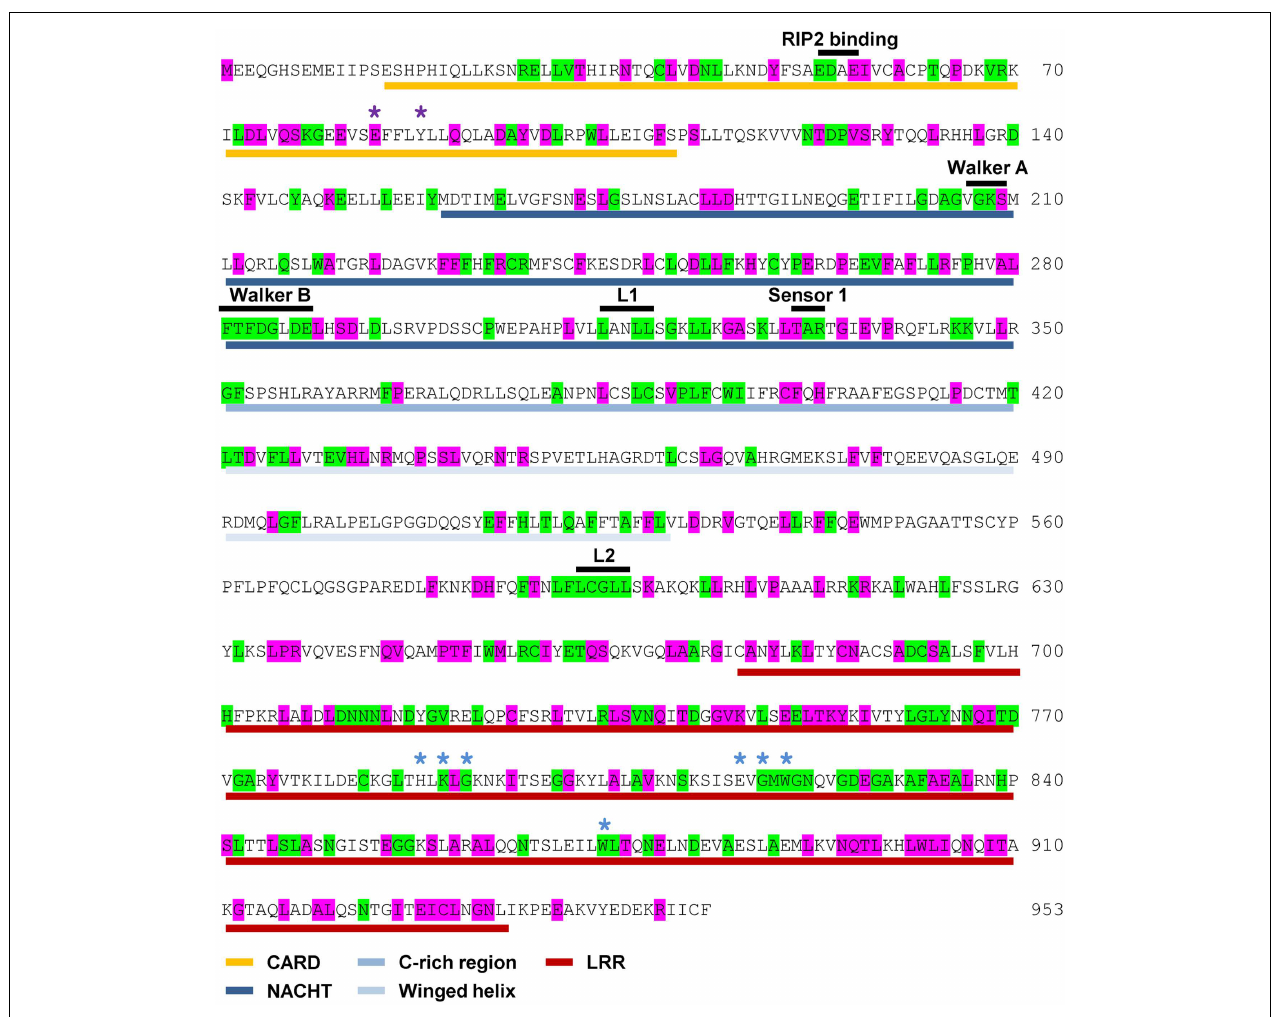
Winged-helix – pale blue; LRRs – red.The motifs responsible for RIP2 binding, theWalker A and B motifs and the Sensor 1 region are all labeled in black above the relevant sequence. Also labeled above the sequence are LxxLL motifs [black bars (L1, L2)], residues predicted to be important for ubiquitin binding (purple asterisks), and residues predicted to be involved in ligand recognition (blue